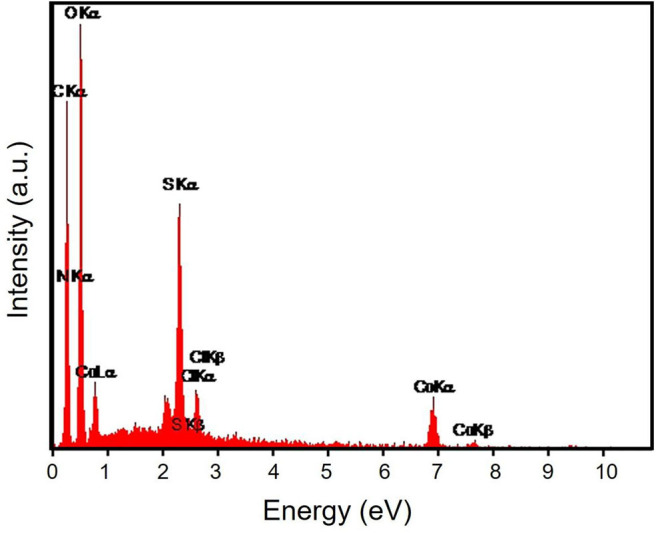
EDS spectrum of Gr/Co3O4 nanocomposite.